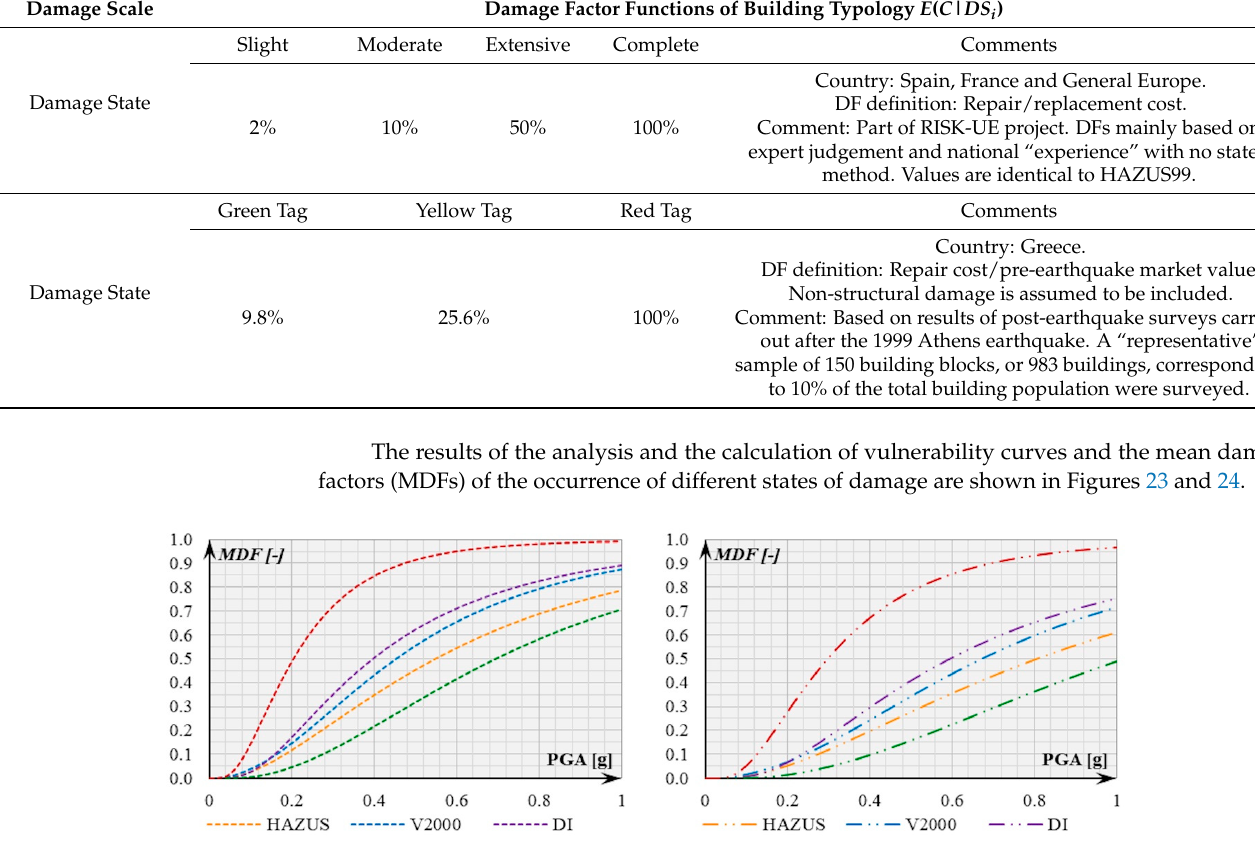
Table 3. Damage factor functions of building typology, for the calculation of vulnerability curves, according to D’Ayala et al. [57]. Damage Scale